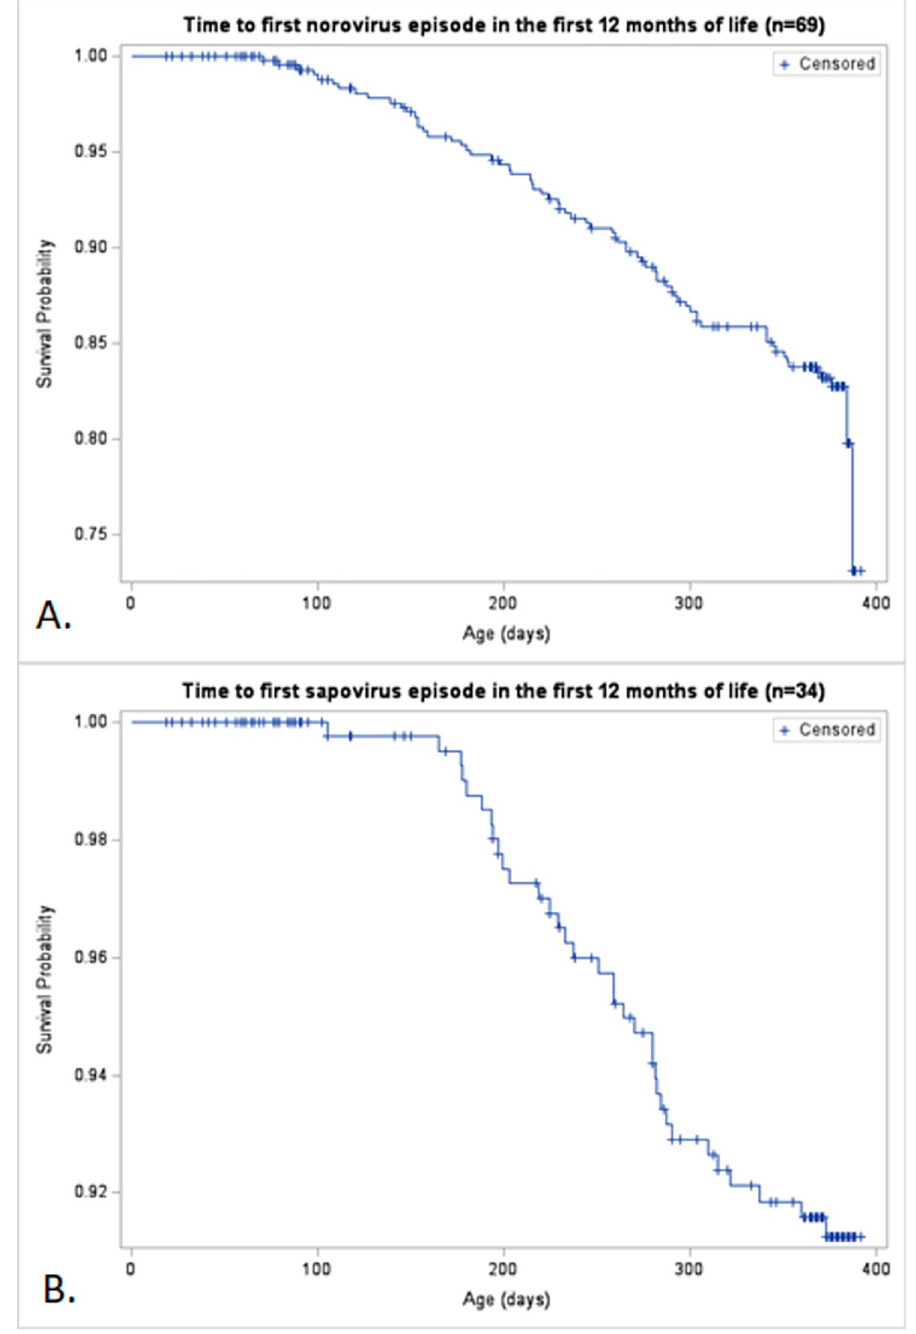
Fig 1. Time to first norovirus and sapovirus AGE episode in the first 12 months of life. This figure illustrates the Kaplan-Meier survival curve for the 69 first norovirus episodes (Panel A), and the 34 first sapovirus episodes (Panel